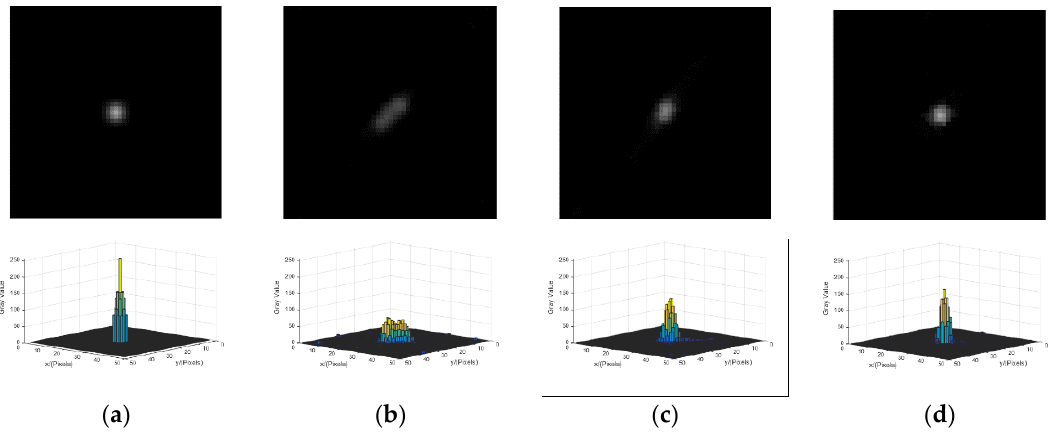
Figure 14. Result of energy distribution after reconstruction with different blur kernels. ( a ) The star spot in the static condition. ( b ) The reconstruction result with blur kernel obtained by the gyroscope. ( c ) The reconstruction result with the blur kernel obtained by the improved Radon transform. ( d ) The reconstruction result with the blur kernel obtained by the proposed method. Table 1. Average centroid position error after reconstruction with different blur kernels.